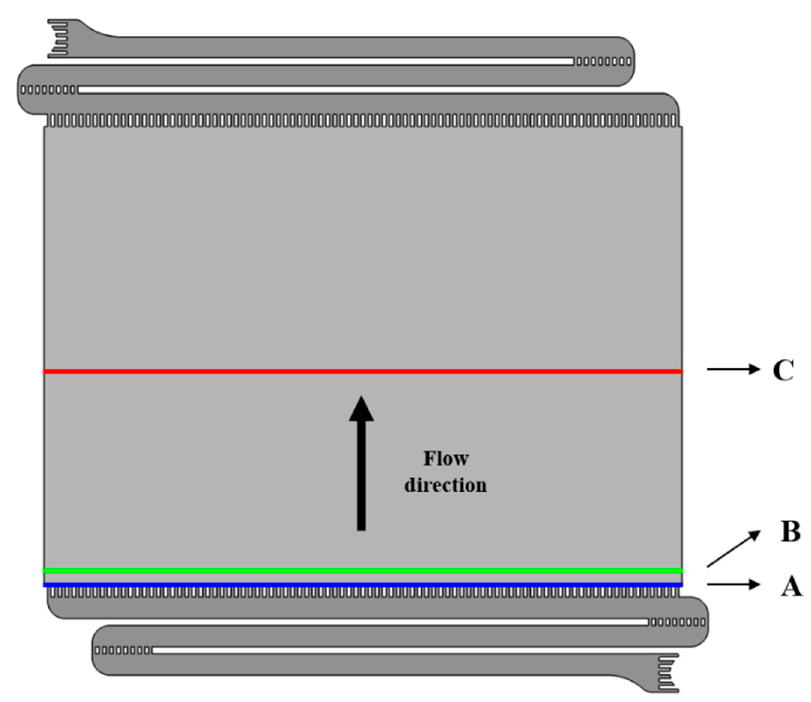
Figure 10. Velocity contours in the ( a ) inlet channel and ( b ) outlet channel of the electrode.